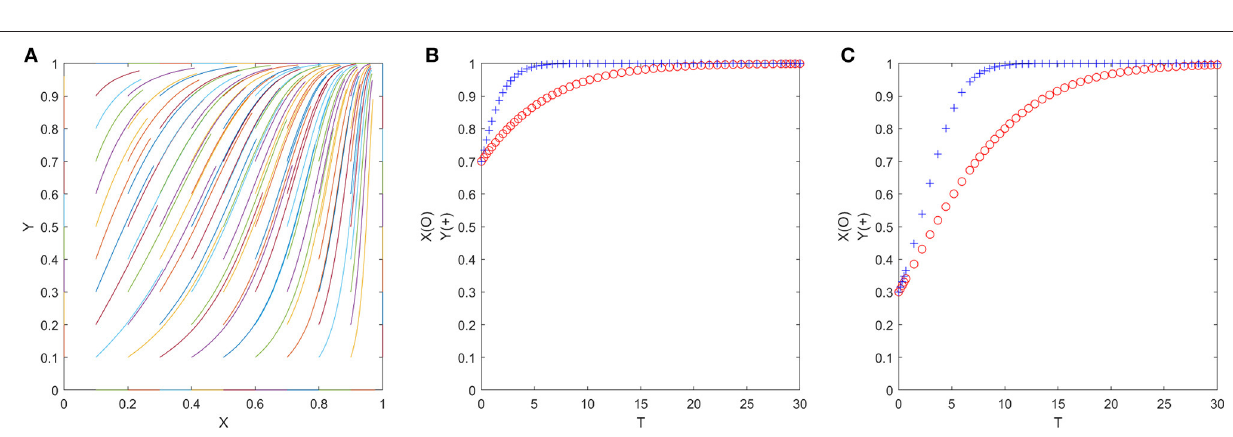
FIGURE 8 | (A–C) The evolution process of the official-folk game under favorable policy parameters (Scenario